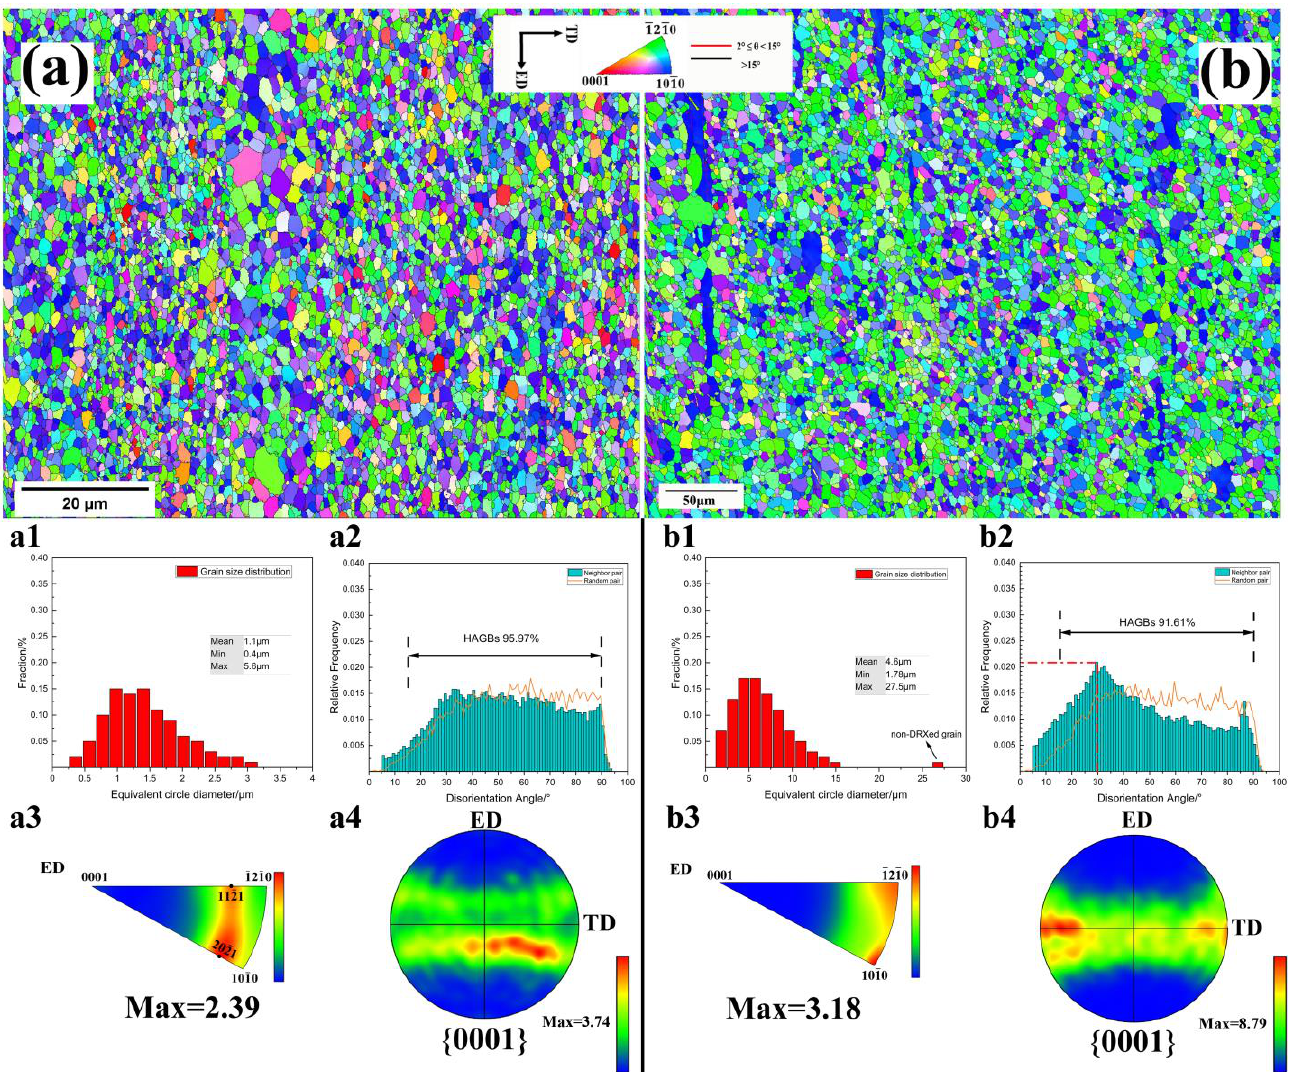
Figure 6. The EBSD analysis result of the as-RS ( a , a1 , a2 , a3 , and a4 ) and as-homogenized ( b , b1 , b2 , b3 , and b4 ) AZ31 hot-extruded rods.